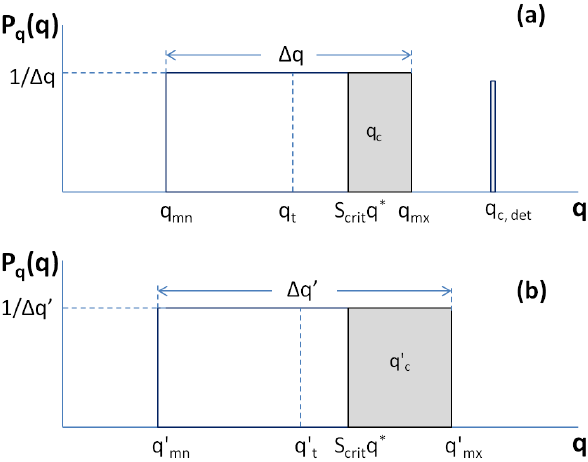
Figure A1. Probability distribution function of total water before (a) and after (b) the microphysics. 1q , q mx and q mn represent the width and the upper and lower limits of the total water distribu- tion, respectively. Shaded regions represent stratiform condensate, q c , and q c , det represents the contribution of convective detrainment to total condensate. Prime superscripts are used to denote values affected by microphysical